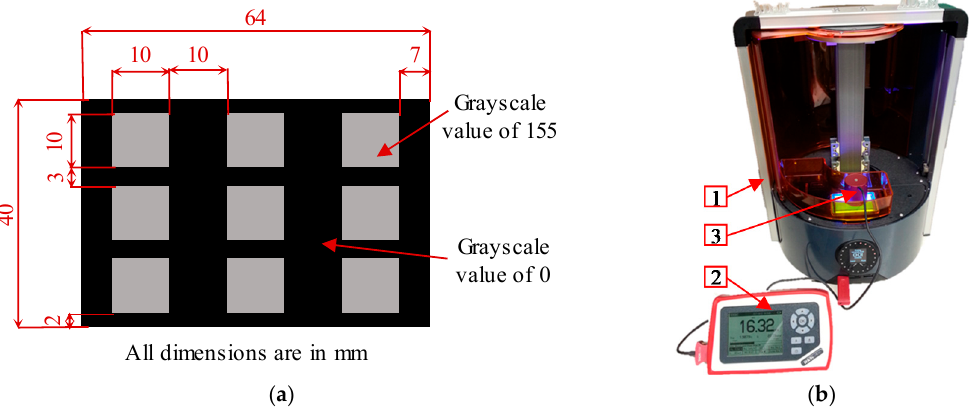
Figure 4. ( a ) A projected image with nine 10 × 10 mm 2 squares having 155 grayscale pixel value, ( b ) measuring the irradiance of the Ember machine using a power meter.